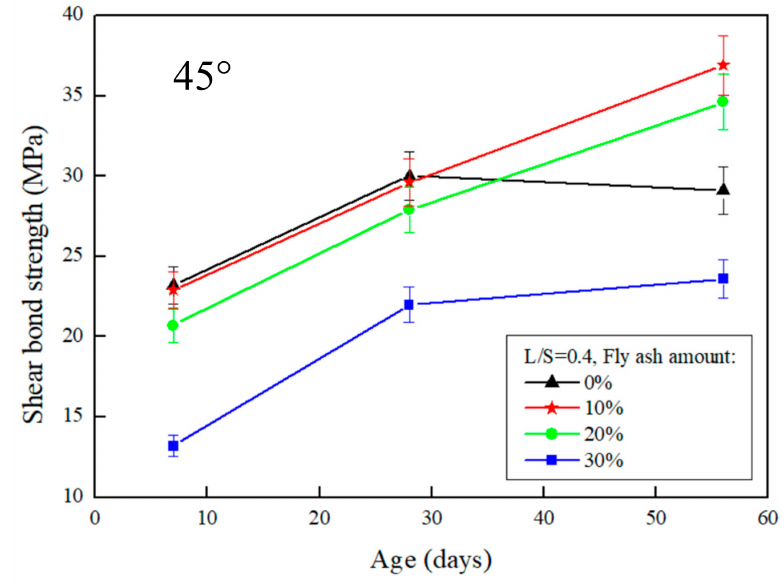
Figure 3. The e ff ect of di ff erent fly-ash amounts on the slant shear test of FGG when L / S = 0.4 and repair angle was 45 ◦